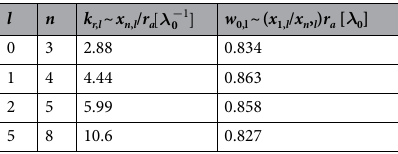
Table 1. Radial index values k r , l ~ x n , l / r a and waist radii w 0,l ~ ( x 1, l / x n , l ) r a that would be associated with intensity patterns similar to those of Fig. 1, produced using an aperture of radius r a = 3 λ 0 , which would admit n rings in